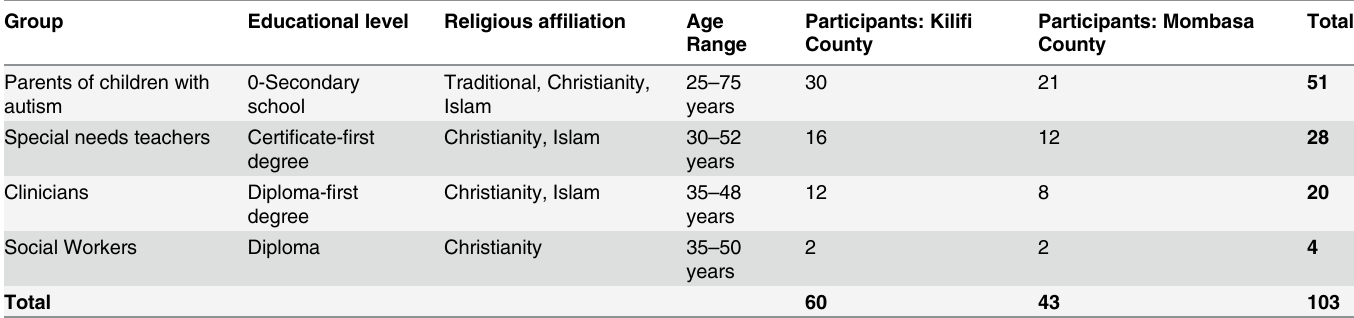
Table 1. Demographic details of